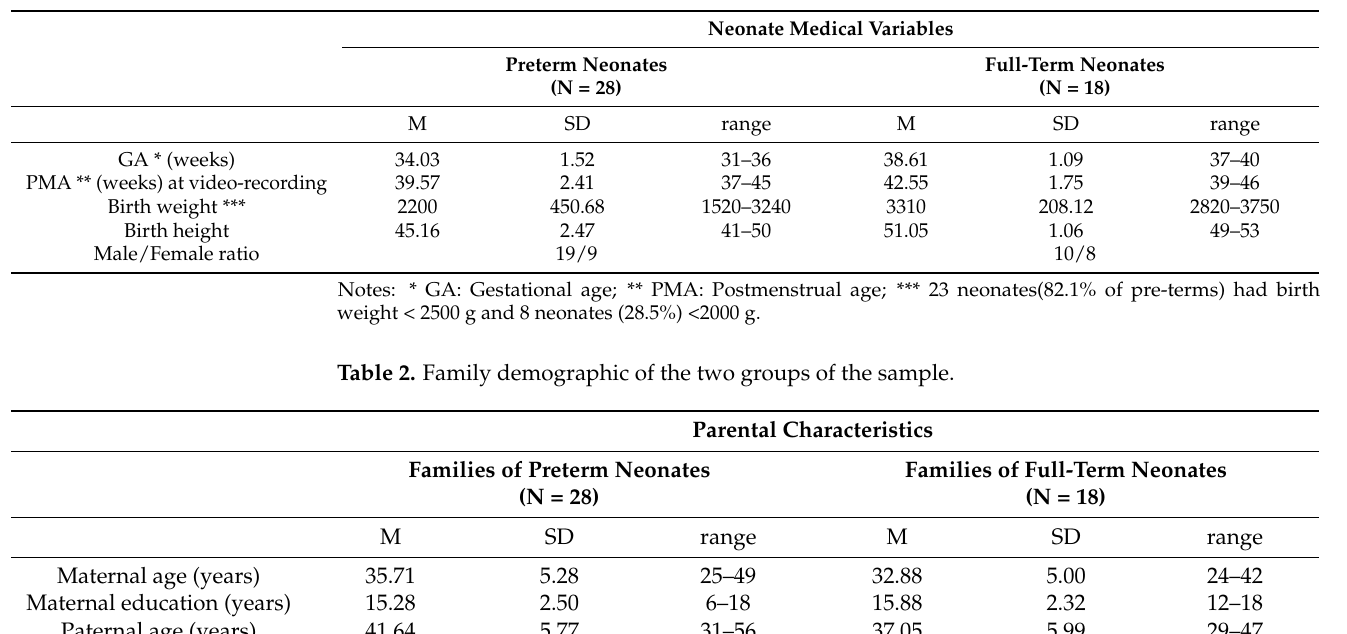
Table 1. Neonate medical variables of the two groups of the sample.